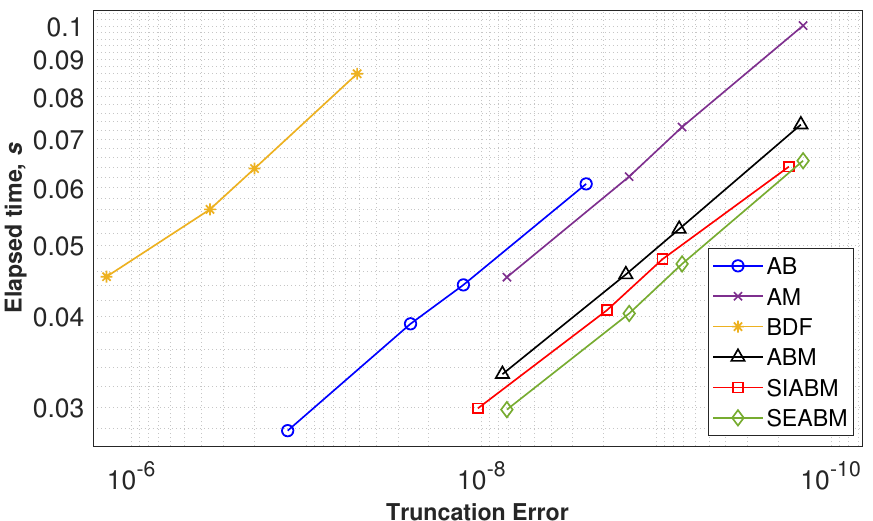
Figure 4. Performance plots for investigated multistep ODE solvers simulating system (7) with variable